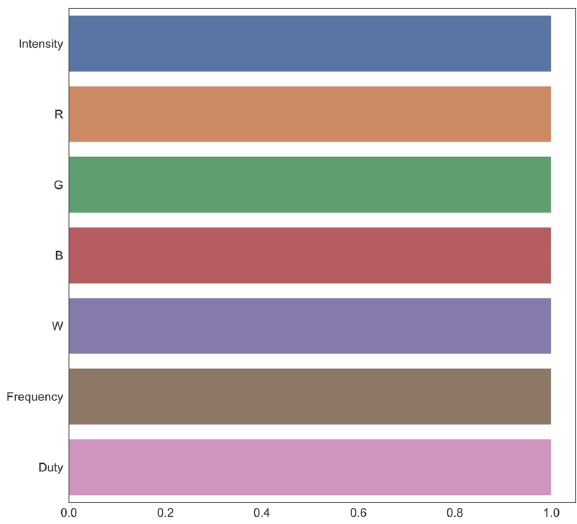
Figure 5. Colors per variable for variance threshold feature selection.